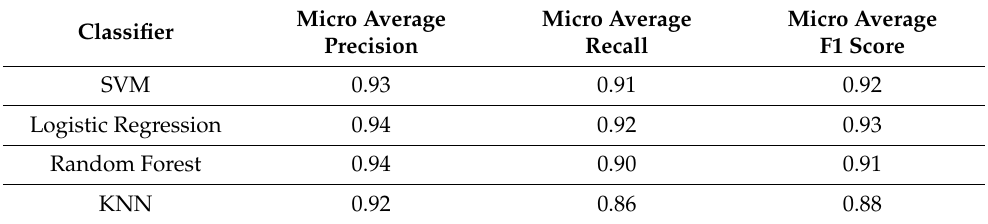
Table 7. Micro average Precision, micro average Recall, and micro average F1 score for each model.